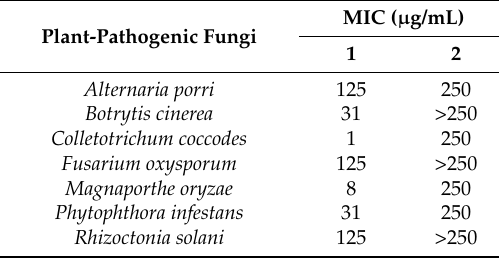
Table 3. Minimum inhibitory concentration (MIC) of crinipellins A ( 1 ) and I ( 2 ) against plant-pathogenic fungi.